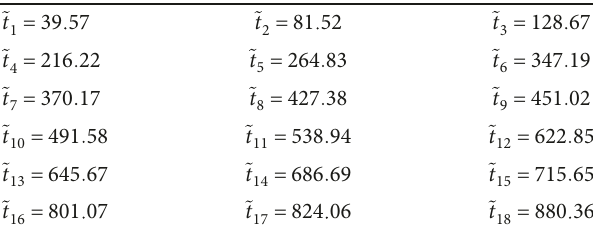
Table 5: Minimum times and computation times in [s] obtained in the numerical experiments for di ff erent numbers of target